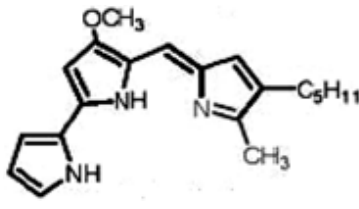
Figure 1. Chemical Structure of Prodigiosin